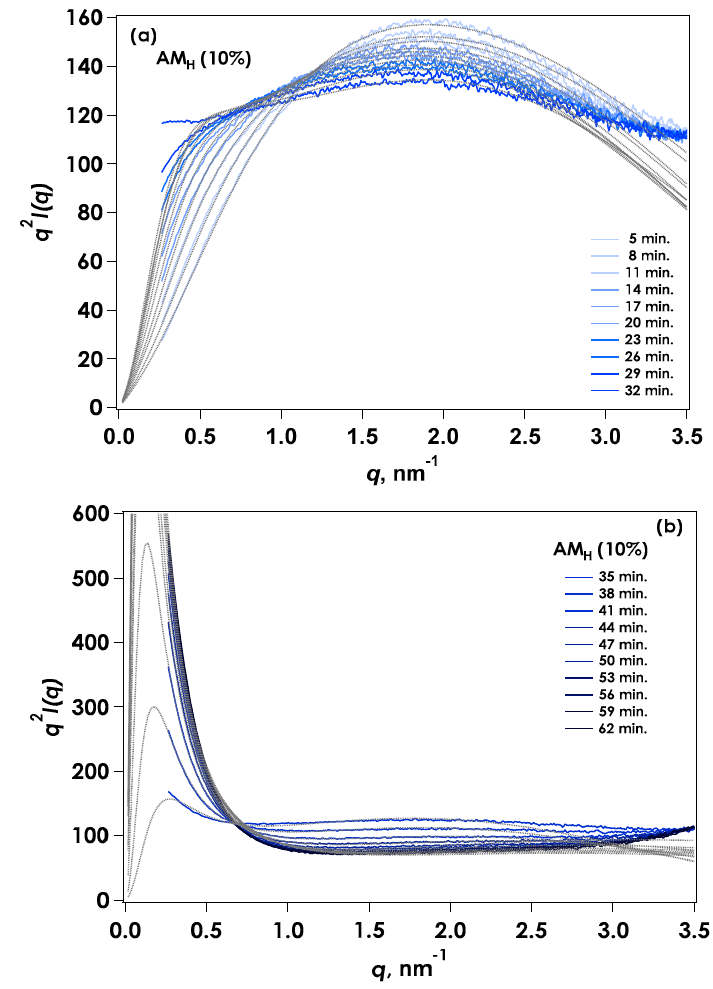
Figure 7. Kratky plots [ q 2 I ( q ) vs. q ] for SAXS from AM H . Dotted lines are fitted curves calculated from Equation (2). ( a ) Initial stage of reaction (5–32 min); ( b ) Final stage of reaction (35–62 min).